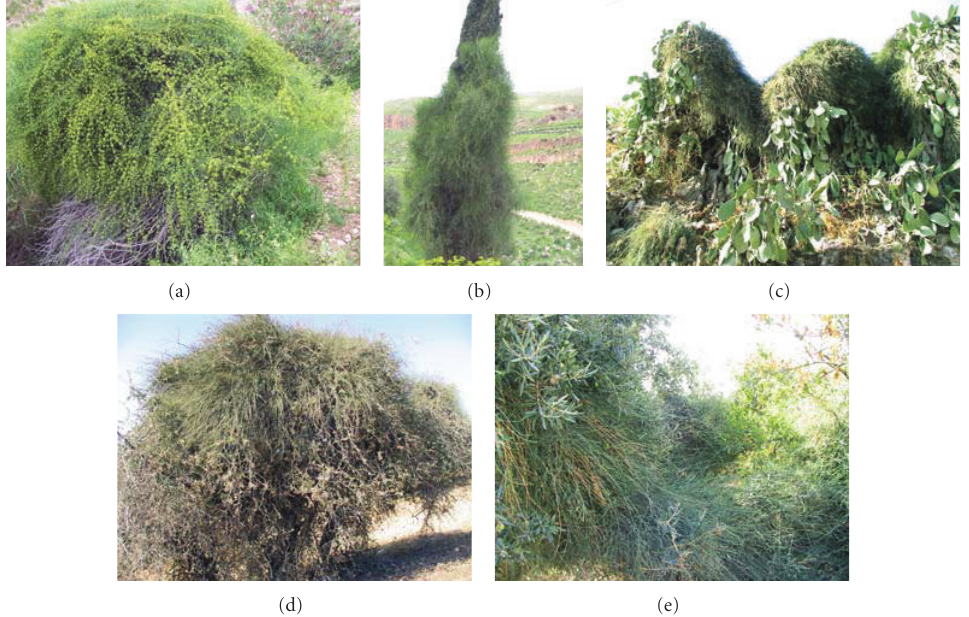
Figure 1: Joint-pine (a) killing Amygdalus communis , (b) climbing Cupressus sempervirens, (c) on Opuntia ficus-indica , (d) killing Rhamnus palaestina, and (e) climbing Olea europaea . Photos Scale: 23% × 23%.